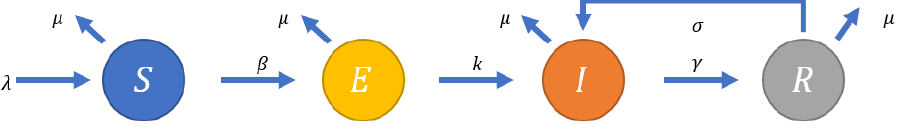
Figure 2. TB-transmission diagram for the 1-age group model (model (1)). Table 3. Age-specific descriptions and initial values (in 2001) from [18,20].